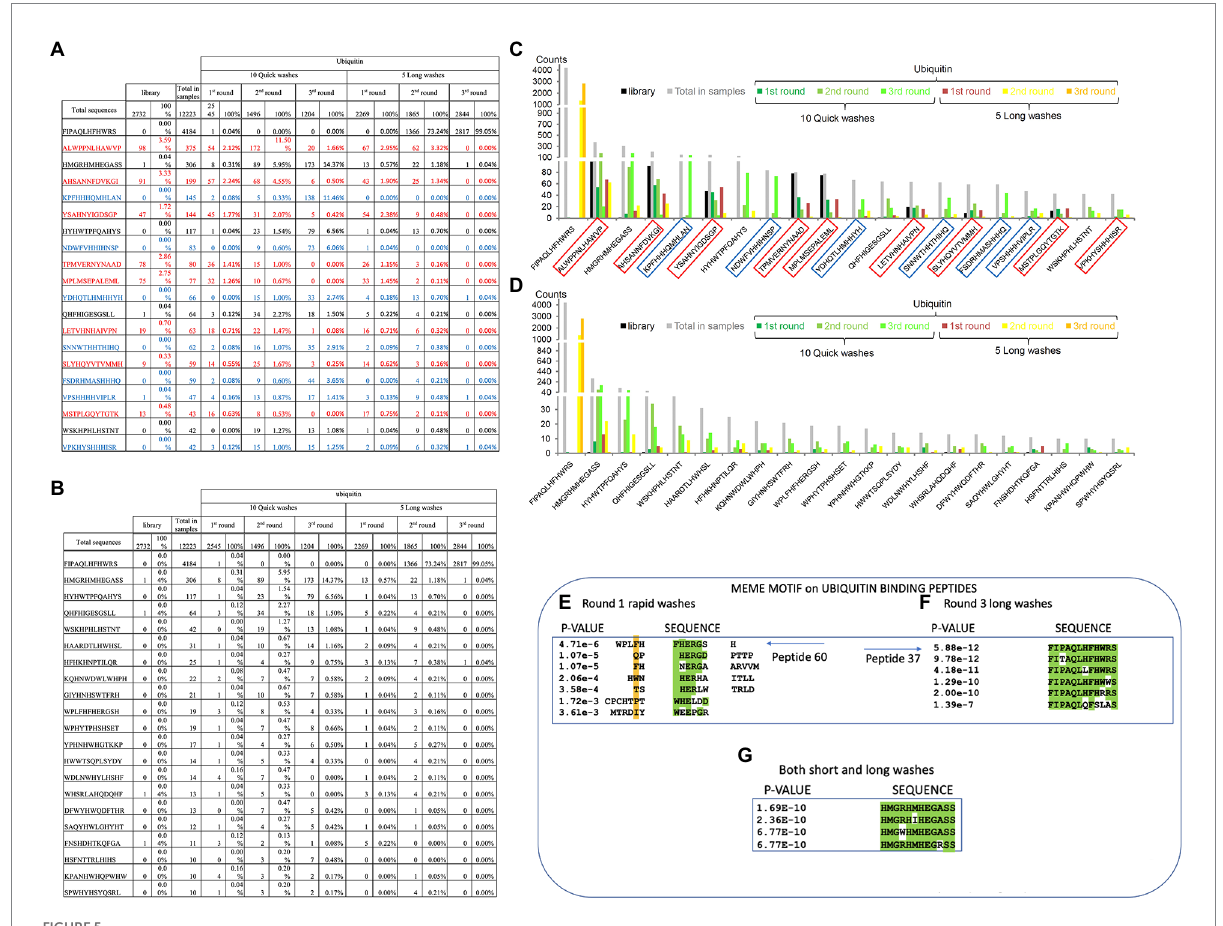
FIGURE 5 Specific peptide sequences enriched from Ubiquitin and NEDD8 peptide-library screens. (A) Peptide sequences enriched against ubiquitin before removal of background peptides. The data summarize the top sequences that were detected after next-generation sequencing was applied to the combined phage pools. The data are segregated based on (I) the rounds (1, 2, or 3); (ii) whether short or long washes were used; and (iii) the number of peptide sequences extracted from each bar-coded sequencing pool (The bar-coded data can also be observed in Supplementary Table 2A). Sequences in red reflect those peptides with a high representation in the parental library and are summarized as the total number of times the peptides were identified and as a percentage of the total sequences for that sequencing tag. For example, the sequence ALWPPNLHAWVP was identified 98 times out of 2,732 sequences with a parental library tag. The parental library bar code was AAA and this number of 98 counts of the sequence ALWPPNLHAWVP can be observed in Supplementary Table 2A. The sequences in red are defined as background due to their high abundance in the parental library and that they are not enriched during the selection process. The sequences in blue contain multiple histidine residues which were also removed to produce the final peptide lists. (B) Peptide sequences enriched against ubiquitin after removal of background peptides. The data summarize the top sequences that were detected after next-generation sequencing was applied to the combined phage pools and the background peptides (summarized in A) are removed. The data are segregated based on (i) the rounds (1, 2, or 3); (ii) whether short or long washes were used; and (iii) the number of peptide sequences extracted from each bar-coded sequencing pool. For example, from the long washes, the sequence FIPAQLHFHWRS was identified 0 times in round 1, 1,366 times in round 2, and 2,817 times in round 3. (C,D) The data from A and B are tabulated for visualization. The data are plotted as peptide count as a function of the indicated sequence. (E–G) The top 60 ubiquitin-selected peptides (from Supplementary Table 3) were evaluated using MEME (motif discovery; https://meme-suite.org/meme/tools/meme). As some examples: (E) Peptide 60 (motif collected from all peptides present in the Round 1 of Rapid washes) exhibited the core motif (W/F)HERG; (F) Peptide-37 (motif collected from all peptides present in Round 3 long washes) exhibited the core motif FIxAQLxFHWRS; and (G) Peptide 33 (from both short and long washes) exhibited the core motif HMGxHMHEGASS. In panels A-C, MEME derives a value of p based on parameters set in meme-suite